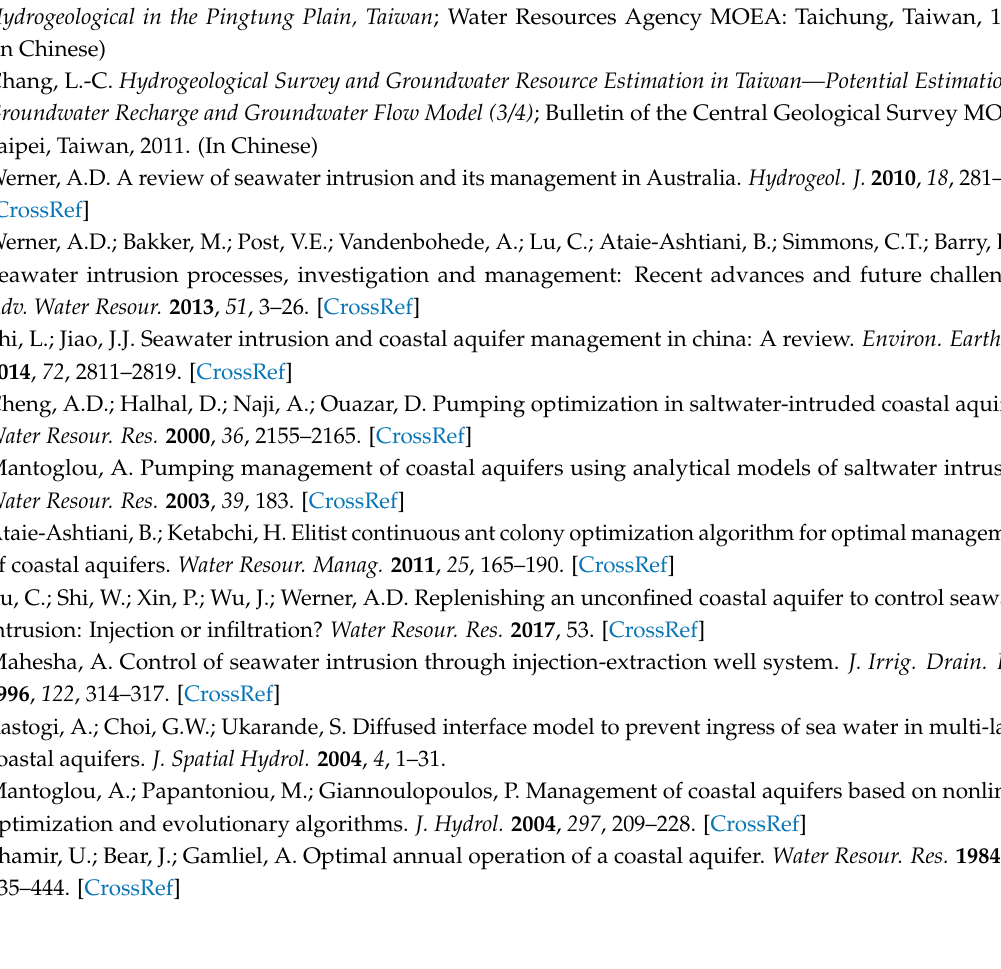
Figure S1: The sensitivity analysis of dispersivity: (a) aquifer F1, (b) aquifer F2, (c) aquifer F3-1. Figure S2: The associated zones of dispersivities: (a) aquifer F1, (b) aquifer F2, (c) aquifer F3-1 (the zones indicated with “*” are the high sensitive zones). Table S1: The water budget of Pingtung Plain in 1999. Author Contributions: Po-Syun Huang and Yung-Chia Chiu conceived and designed the experiments; Po-Syun Huang performed the experiments; Po-Syun Huang and Yung-Chia Chiu analyzed the data; Po-Syun Huang and Yung-Chia Chiu wrote and revied the paper. Conflicts of Interest: The authors declare no conflict of